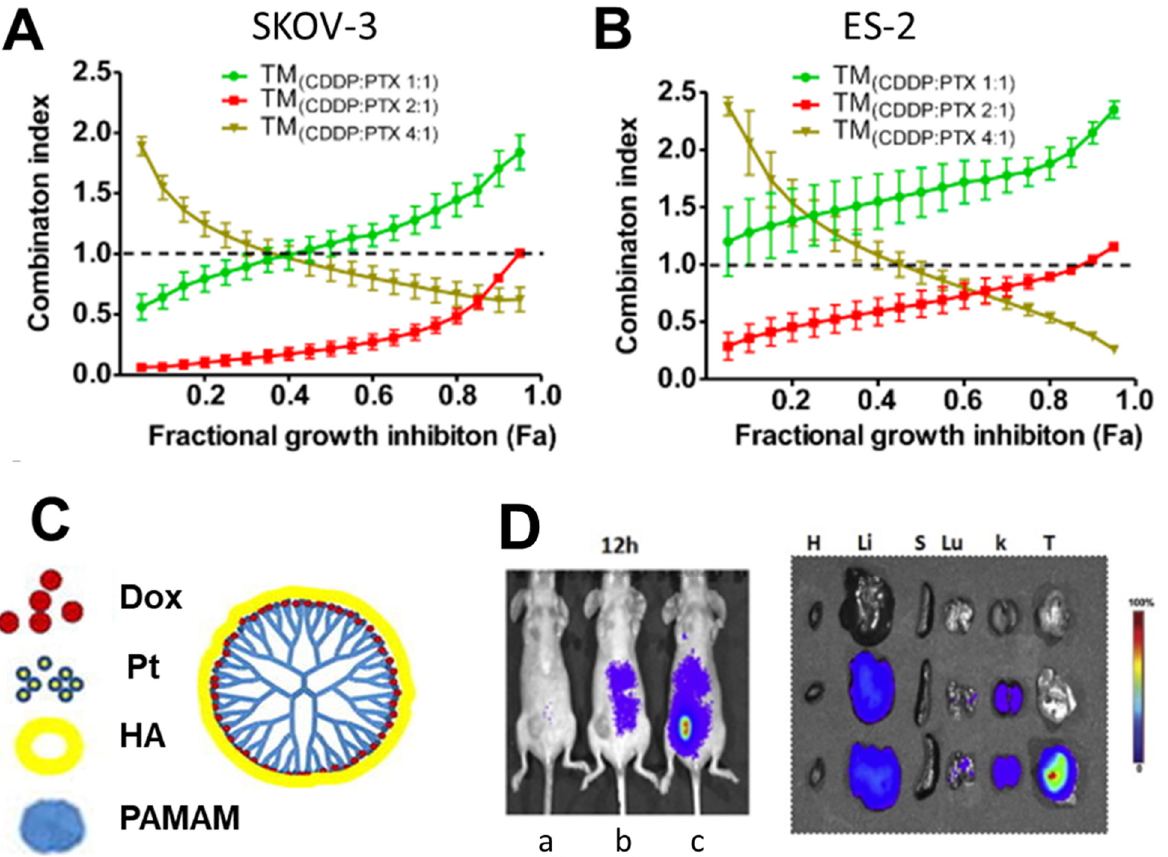
Figure 7. Combination index of ( A ) SKOV-3 and ( B ) ES-2 cells treated with telodendrimer nanocarriers loaded with paclitaxel and cisplatin (CDDP) at different ratio. The telodendrimers produce different drug interaction due to drug ratio and cell type. Reprinted from [119], Copyright 2015, with permission from Elsevier. ( C ) Schematic of polyamidoamine (PAMA) dendrimer formulated with hyaluronic acid (HA) loaded with cisplatin (Pt) and doxorubicin (Dox). ( D ) In vivo co-delivery of cisplatin with doxorubicin in polyamidoamine dendrimers enhance drug accumulation in tumor tissue facilitated by hyaluronic acid targeting ligands. (a: saline; b: Cy7.5-labeled PAMAM; c: Cy7.5-labeled HA@PAMAM). Reprinted from [120], Copyright 2019, with permission from Elsevier.